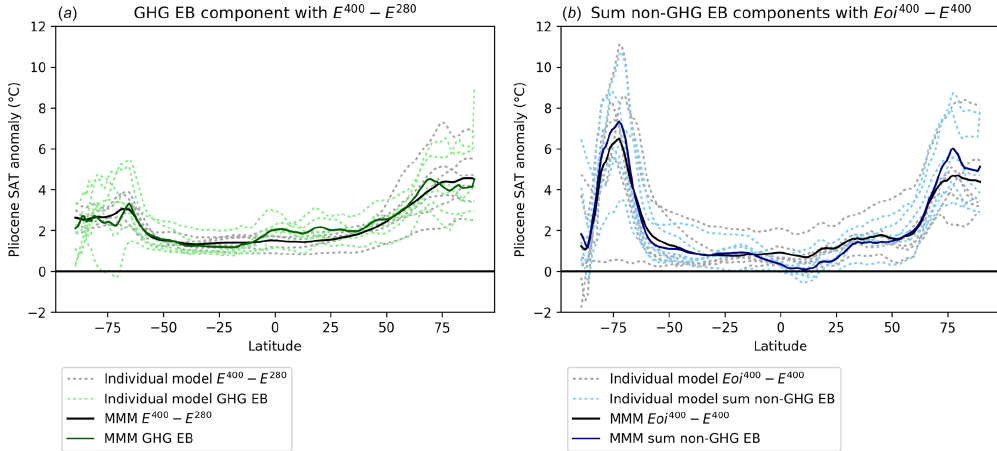
Figure 3. Comparison of the greenhouse gas (GHG) energy balance component ( (cid:49)T gg ε ) and the E 400 –E 280 SAT anomaly (a) and equivalent comparison of the sum of non-greenhouse gas energy balance components and the Eoi 400 –E 400 anomaly (b) . The MMM is shown in a solid line, and individual models are shown by dotted lines, representing uncertainty between